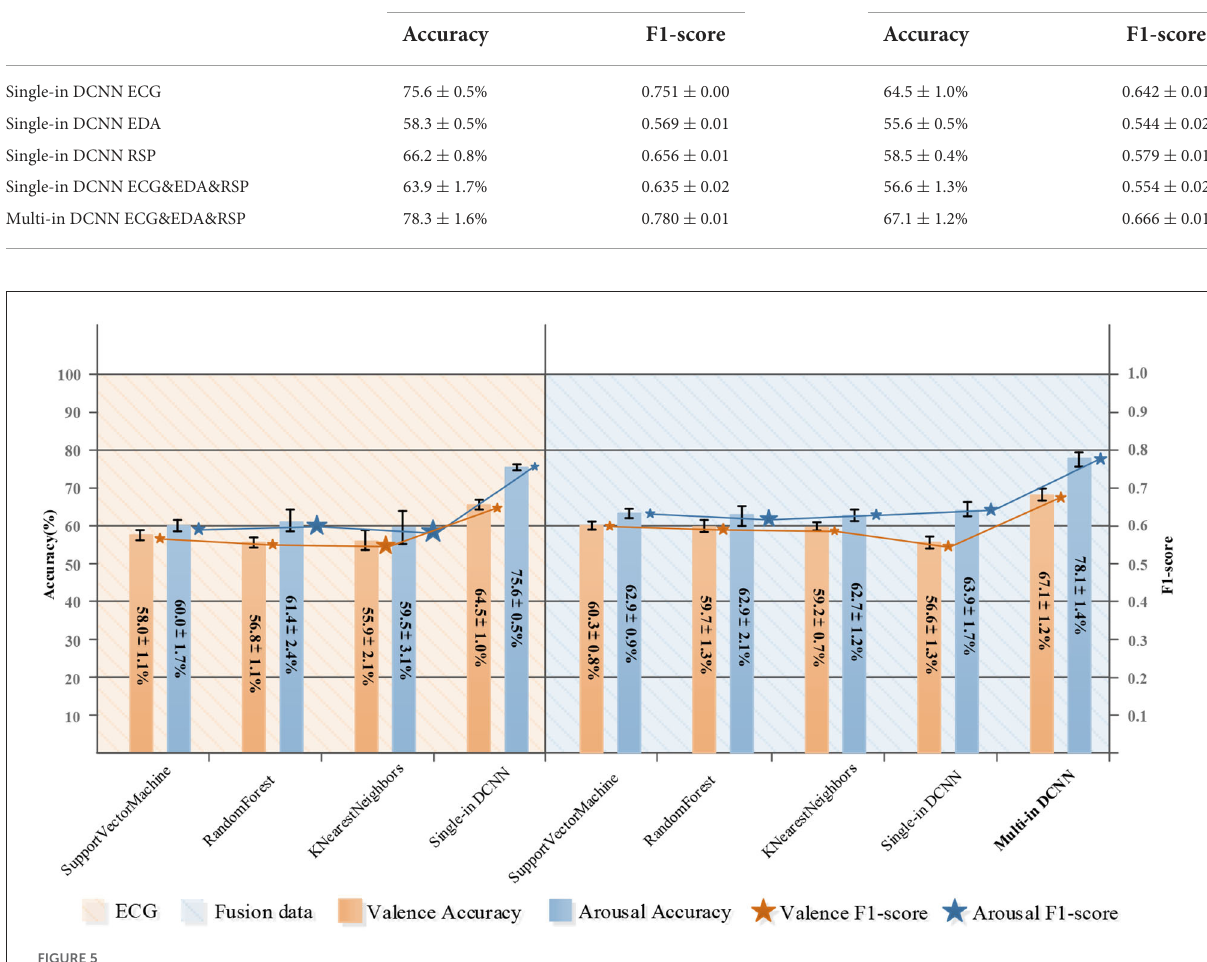
FIGURE5 Comparison of emotion classification based on ECG and ECG&EDA&RSP fusion